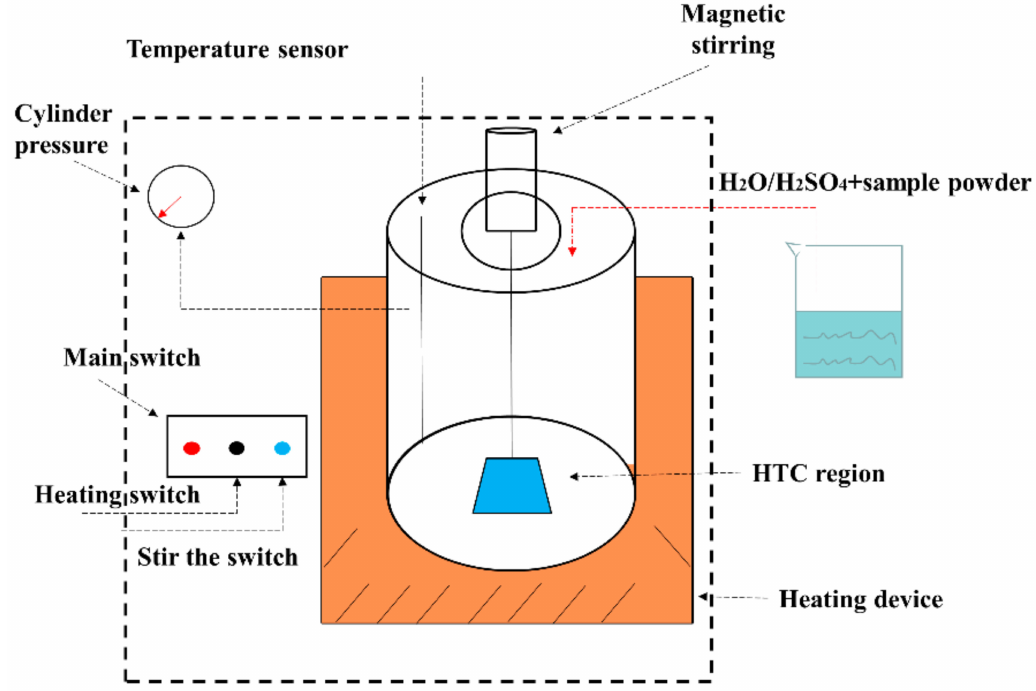
Figure 2. Diagram of hydrothermal carbonization of food waste powder. (HTC: hydrothermal